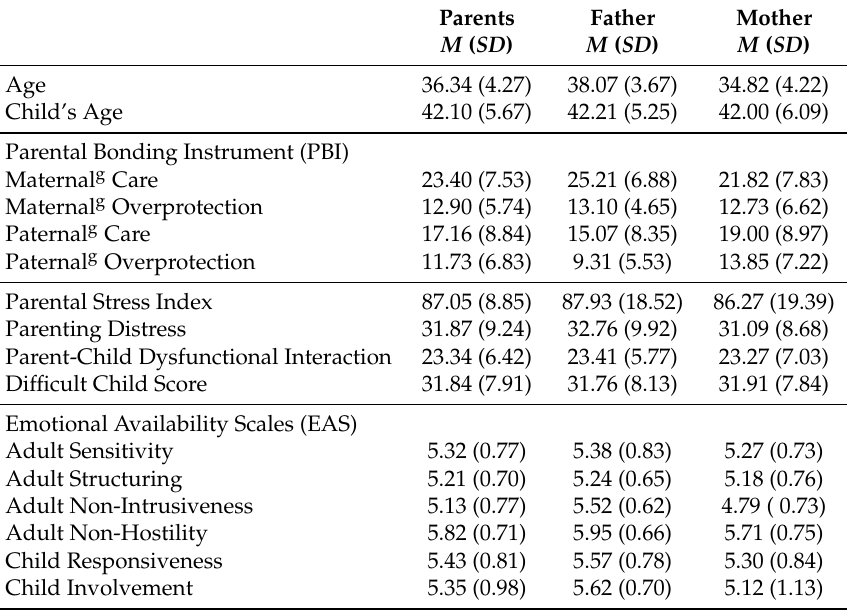
Table 1. Descriptive data for pooled father–child and mother–child samples (Parents), for the father–child sample (Father), and for the mother–child sample (Mother). Notes. M ( SD ) = mean (standard